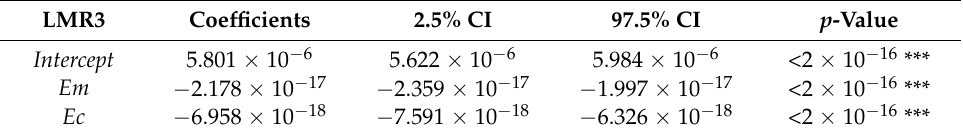
Table 8. Regression statistic: case 3.2.2—Thinner core.